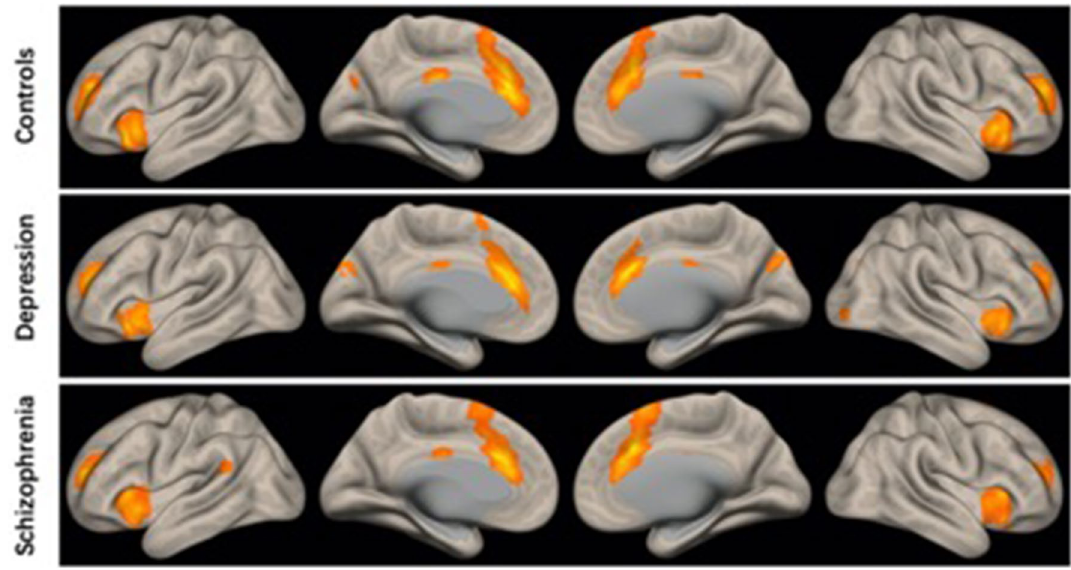
Figure 2. T maps of functional connectivity with the SN and whole brain in the three groups. One-sample t-test was performed for each group (voxel-wise p < 0.001 uncorrected and a cluster-wise threshold of p < 0.05, FWE-corrected).